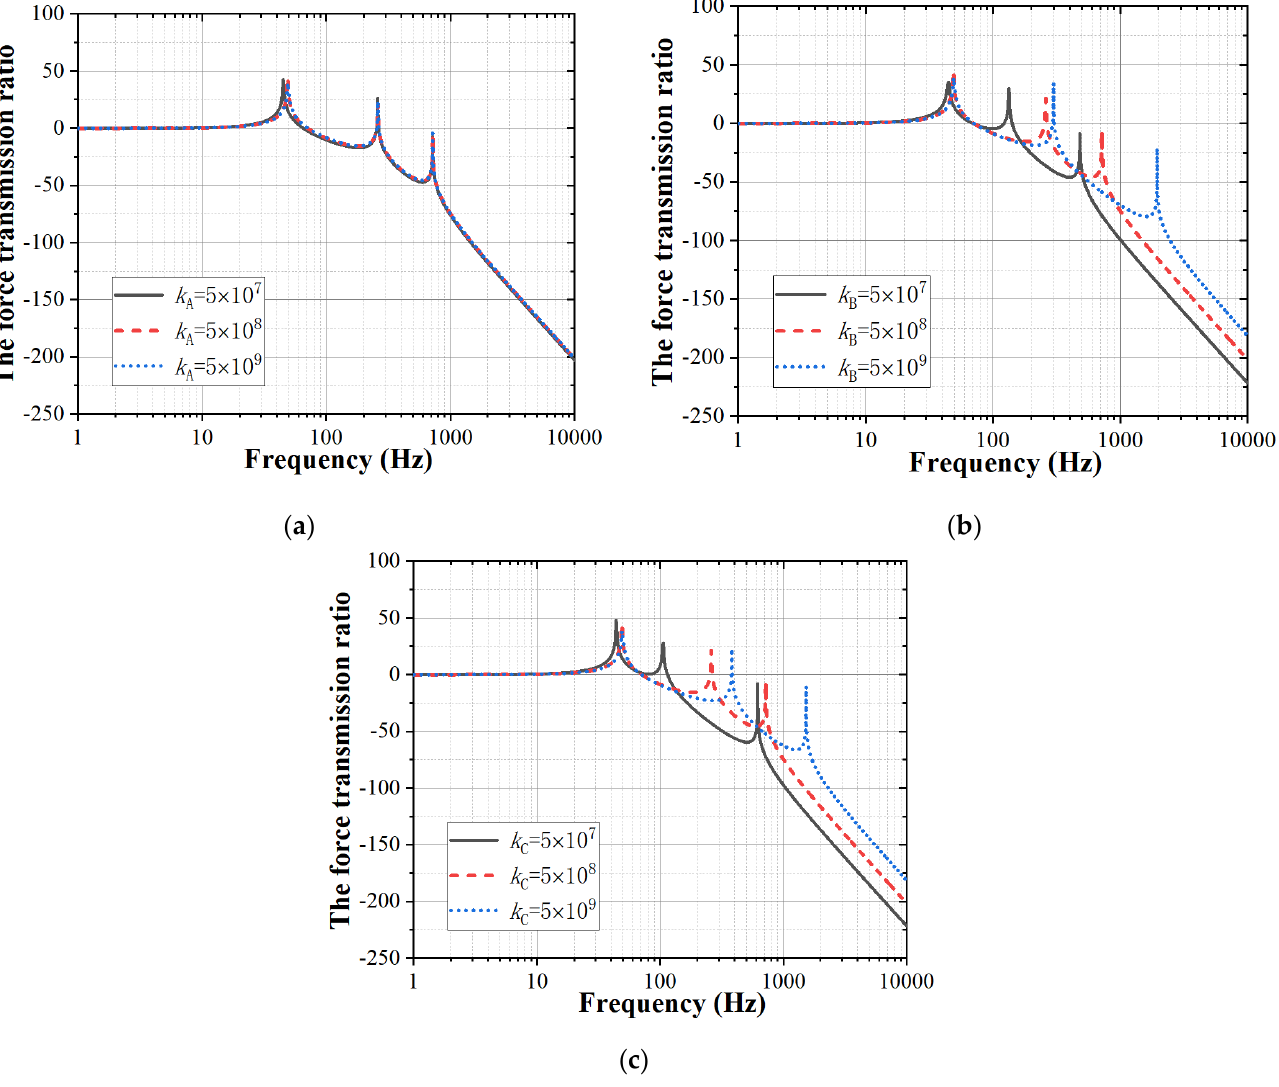
Figure 9. The force transmission ratio of the single-stage vibration isolation with ( a ) different power system stiffnesses, ( b ) different battery stiffnesses, and ( c ) different wing stiffnesses.